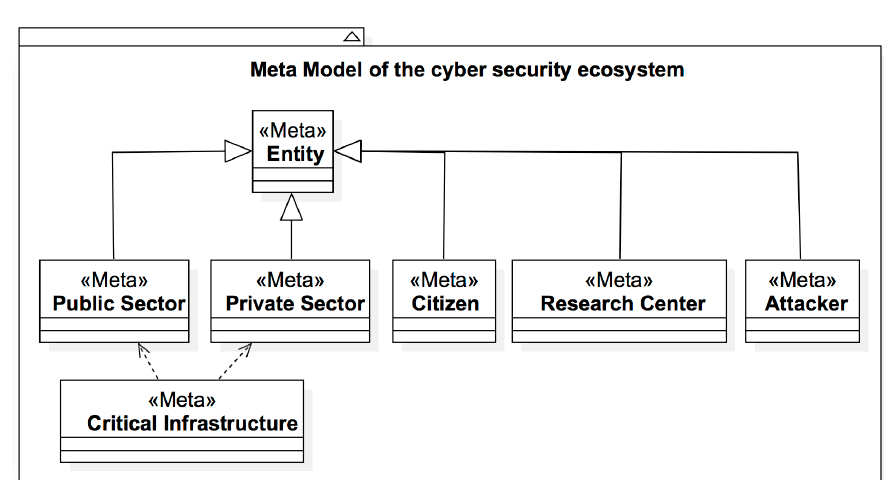
Figure 13. Meta Model of the Cyber security Ecosystem of Colombia.